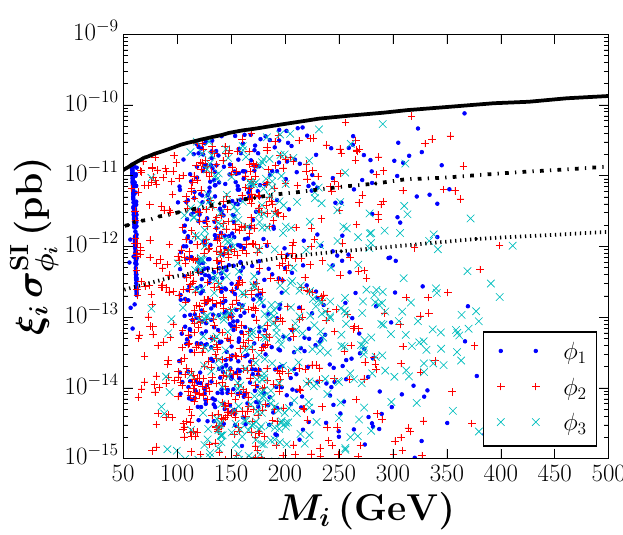
Figure 10 . Detection prospects in the scan with µ S 3 , λ 34 , λ 4 ij 6 = 0 (scan D). The solid line is the current LZ limit whereas the dotted lines correspond to the expected sensitivities of LZ and